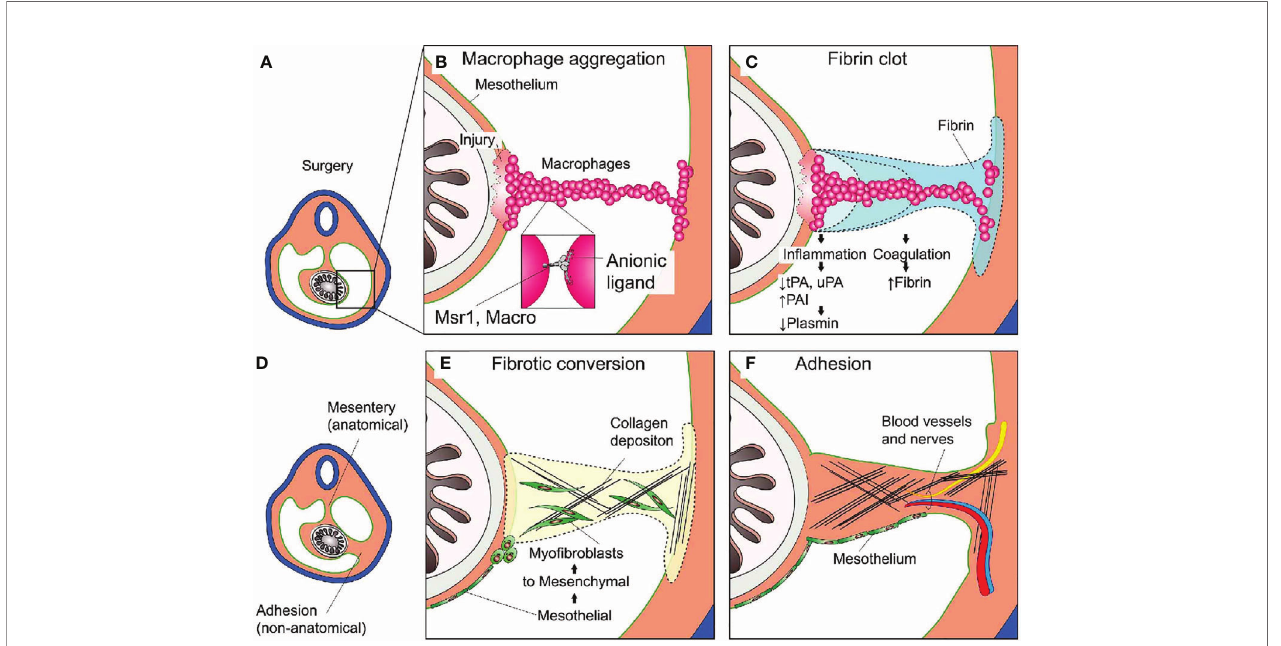
FIGURE 4 | Post-surgical adhesion formation. (A) Overview of the peritoneal cavity before surgery. (B) Non-focal mesothelial injury such as major abdominal surgery leads to the uncontrolled aggregation of peritoneal macrophages serving as the nidus for the (C) subsequent Fibrin clot deposition. In fl ammation and Coagulation inter-dependently promote the deposition of fi brin (see text). (D) Overview during or after adhesion formation. The abdominal organs (e.g., intestine) are now attached to the abdominal wall at anatomic (mesentery) and non-anatomic (adhesion) locations. (E) Mesothelial to mesenchymal transition gives rise to myo fi broblasts that migrate into the wound and into the fi brin clot where they start to deposit extracellular matrix (ECM) such as collagen. (F) Adhesion formation is completed when the scar tissue is covered with mesothelium. The lesion may become fully perfused and pain-sensitive by ingrowth of blood vessels and